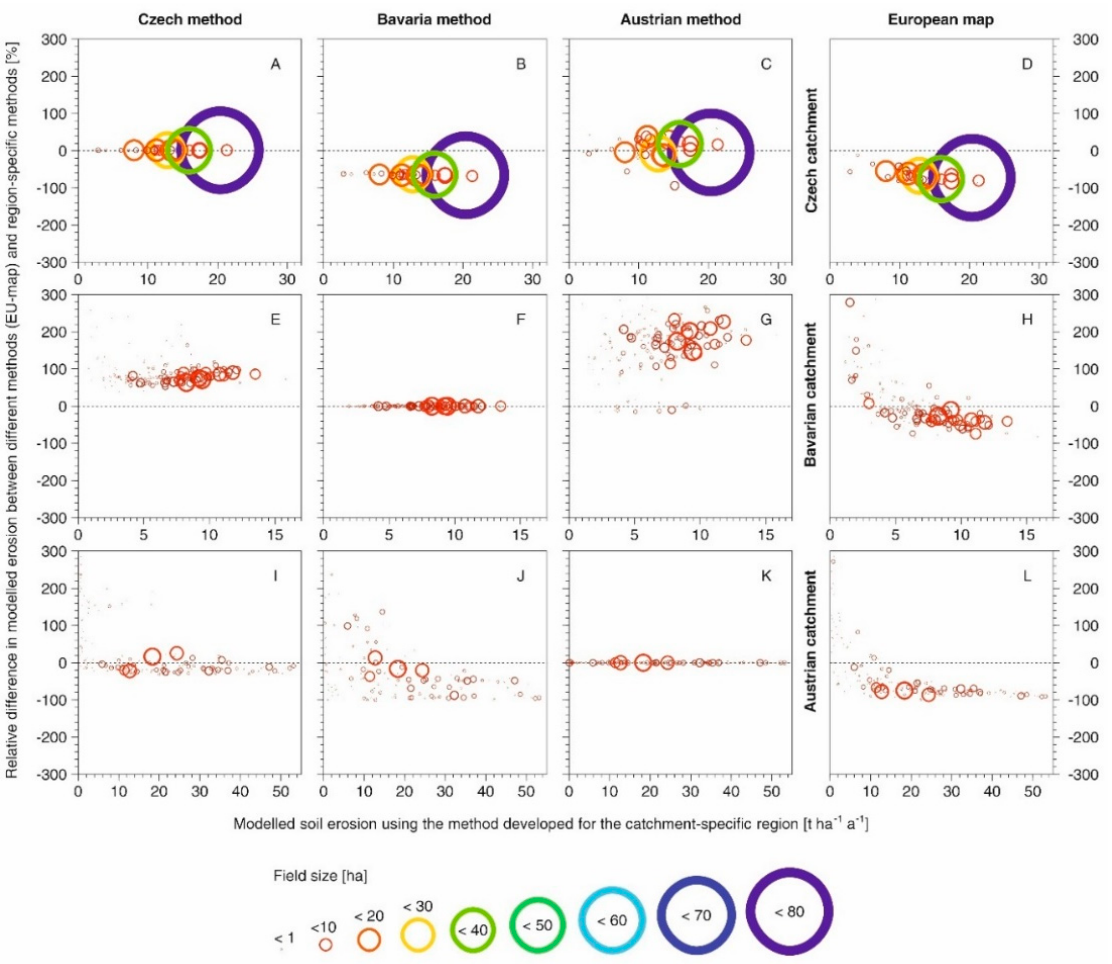
Figure 4. Relative difference between field erosion modelled with different methods (and EU map [19]) and the method potentially best representing the catchment (e.g., in the CZ catchment: Czech ( A ), Bavarian ( B ), Austrian methods ( C ), and European map ( D ) vs. CZ method). Each data point represents the mean soil loss of a field.